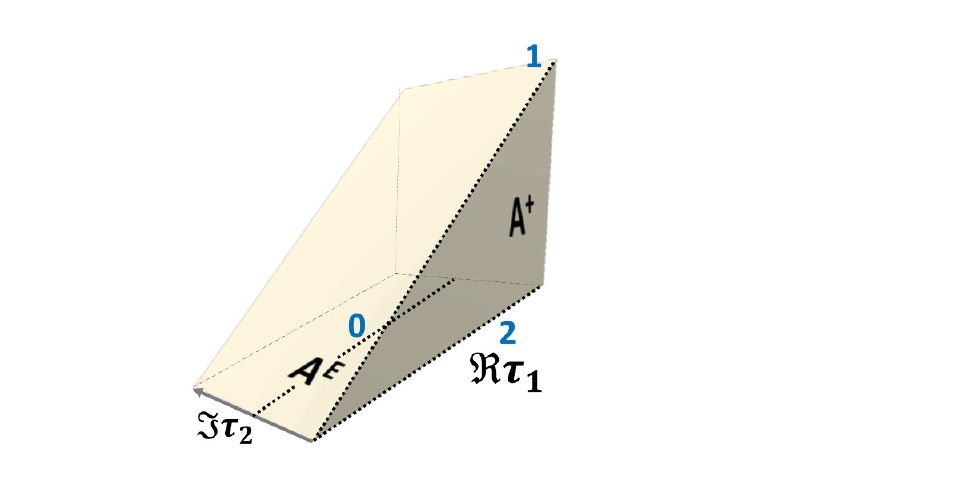
Figure 3 . A 3-dimensional slice of the fundamental domain D 2 for the BC 2 Calogero-Sutherland model in (cid:28) -space with = (cid:28) 1 = 0. Front and back side of the wedge should be identi(cid:12)ed. The (cid:12)xed points (walls) under the action of w 2 and w 1 are shown as bold dashed lines. Fixed points of w 2 fall into two disconnected components which carry the labels 0 and 2. The shaded area in front is the Weyl chamber A + . It is bounded by the walls ! 1 and ! 2 . The subset A E is the 2-dimensional 2 2 semi-in(cid:12)nite strip of width 2 (cid:25) on the bottom of the wedge. It is bounded by the wall ! 2 , whereas wall ! 0 cuts through its